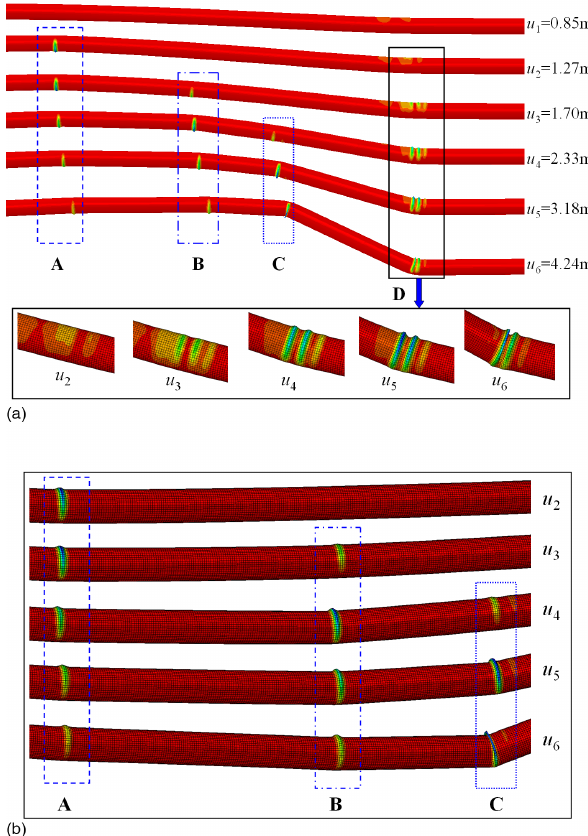
Figure 5. Buckling behaviors of the buried pressure pipeline under different reverse fault displacements. (a) Buckling of the pipeline and (b) local amplification figure.